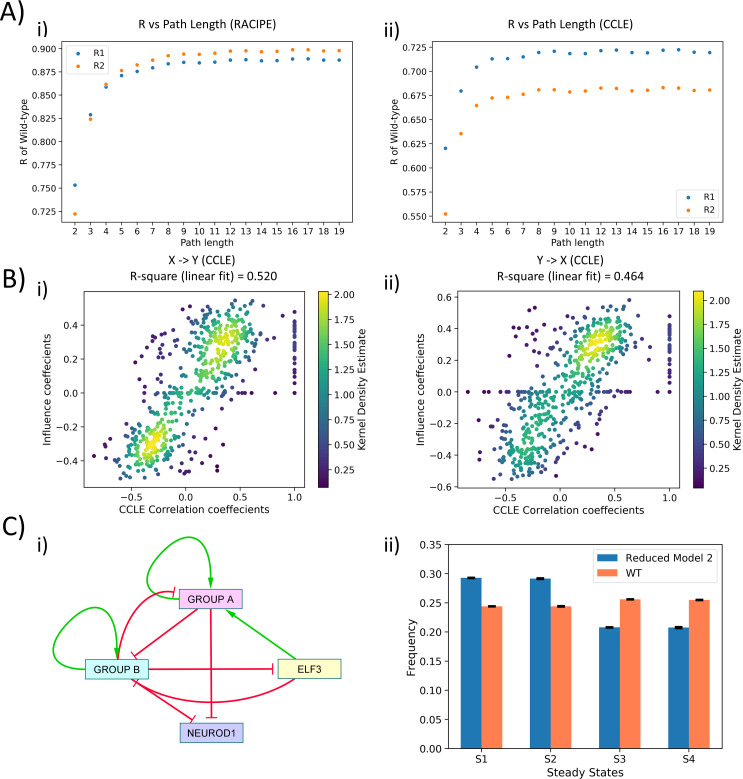
Topological features.(A) Scatter plot of R1 and R2 values obtained for varying path lengths, when influence matrix values/coefficients (for varying path lengths) for WT SCLC network were regressed against correlation coefficients from (i) RACIPE and (ii) CCLE. (B) (i) Scatter Plot of R1 and R2 values of influence coefficients of WT network and CCLE correlation coefficients for path length = 10. (C) (i) Reduced model derived from interaction matrix; red bars show inhibition, and green arrows show activation. (ii) Steady-state frequencies obtained from reduced model one and that of WT SCLC network (n = 3).